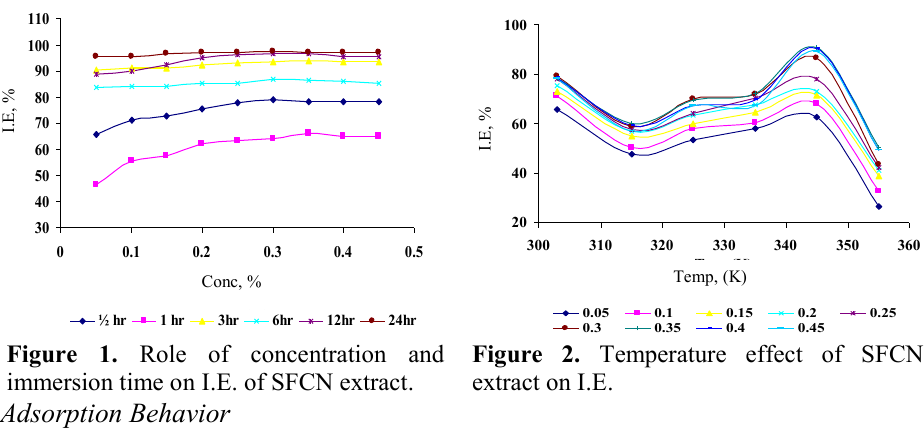
Figure 1. Role of concentration and immersion time on I.E. of SFCN extract.